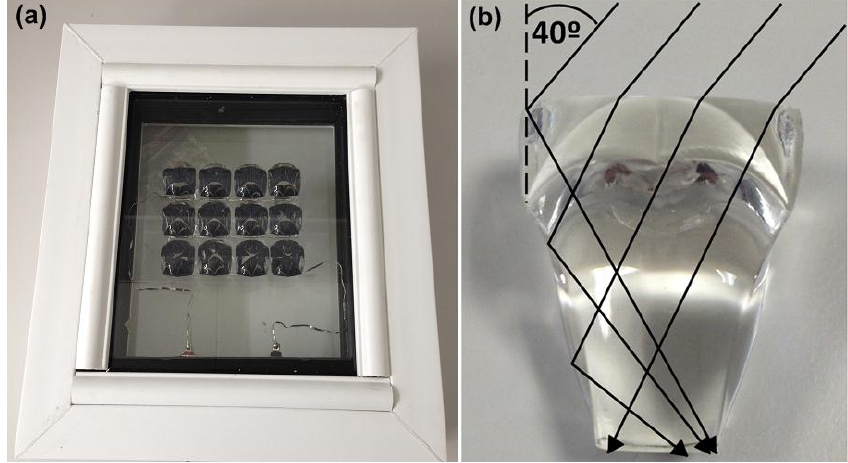
Figure 3. ( a ) A concentrating PV (CPV) window incorporating rotationally asymmetrical dielectric totally internally reflecting concentrators (RADTIRCs); and ( b ) the half-acceptance angle of the RADTIRC.